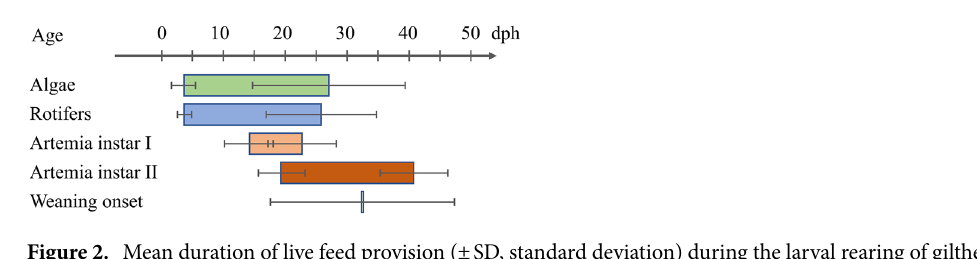
Figure 2. Mean duration of live feed provision (± SD, standard deviation) during the larval rearing of gilthead seabream in four European hatcheries. dph, days post